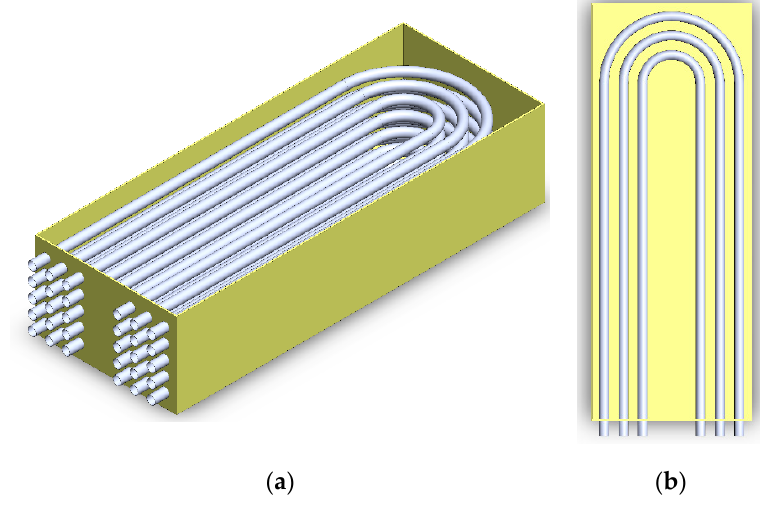
Figure 6. S hell-and-tube heat exchanger for LHTES reproduced from [8], ( a ) 3D view ( b ) Top